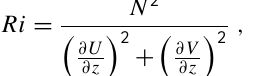
periods and durations of these selected episodes was 5.5